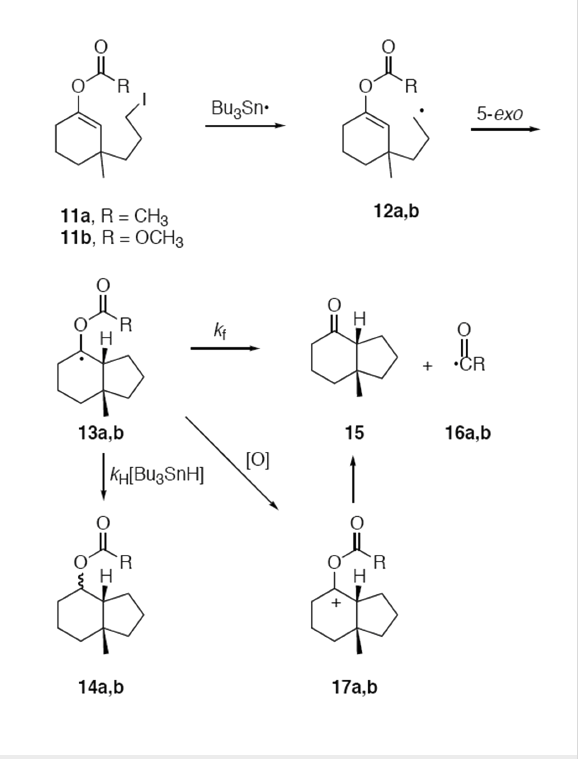
Figure 4: Competing mechanistic pathways for reaction of 11 with Bu 3